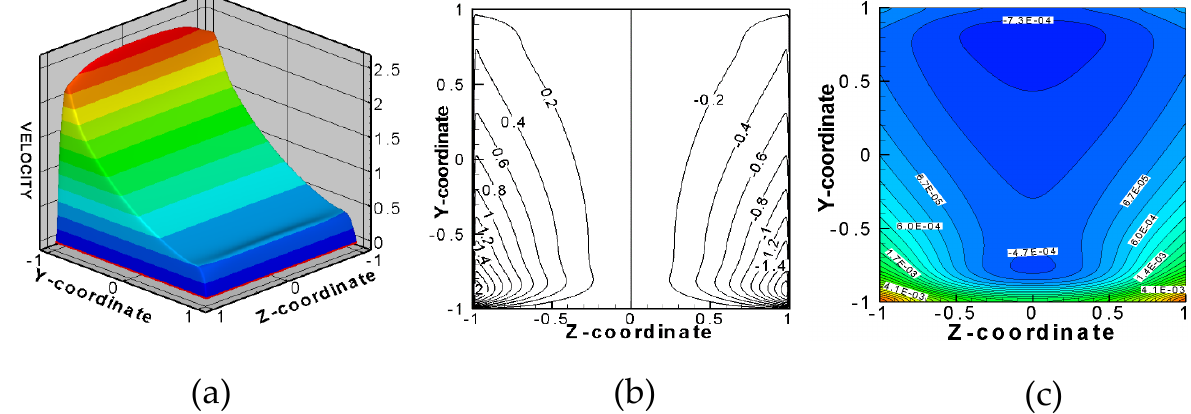
Figure 10. Computed MHD fully developed upward (buoyancy-assisted) mixed convection flow of PbLi in a non-conducting square duct with volumetric heating at Ha = 200, Re / Gr = 10 3 and m = 1: ( a ) velocity distribution, ( b ) induced magnetic field, and ( c ) temperature.